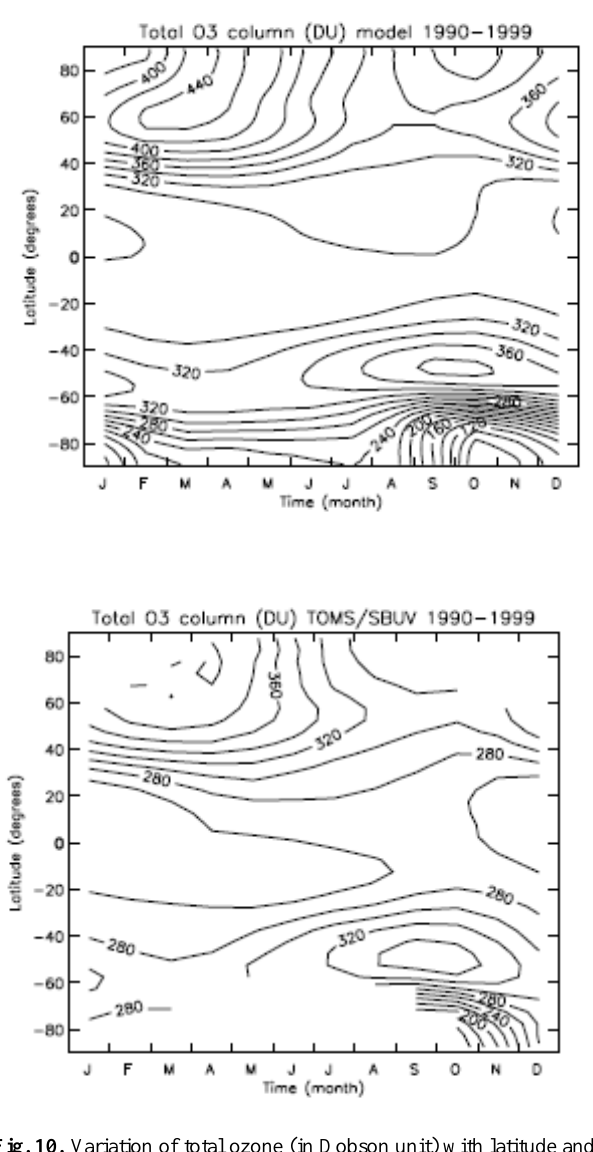
Fig. 10. Variation of total ozone (in Dobson unit) with latitude and time (month); top panel: mean value for the last 10 years of the sim- Figure 10: Variation of total ozone (in Dobson unit) with latitude and time (month); 4 ulation (1990–1999), bottom panel: mean value of TOMS/SBUV observations for the period top panel: mean value for the last 10 years of the simulation (1990-1999), bottom 5 panel: mean value of TOMS/SBUV observations for the period 1990-1999. 6